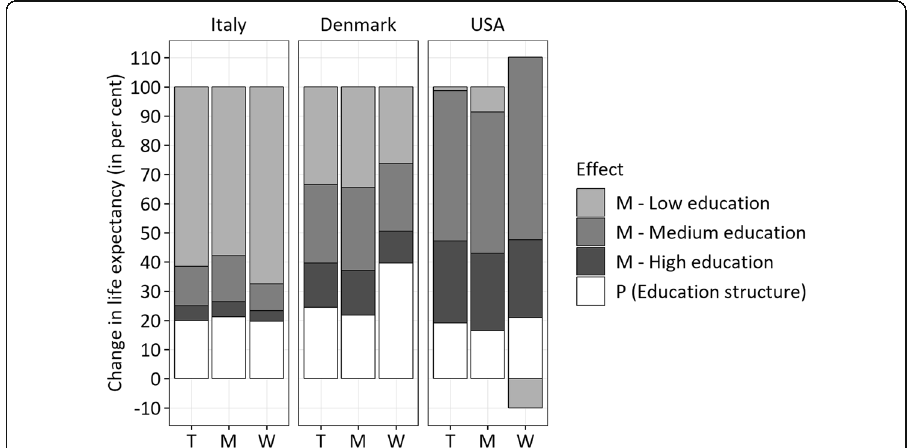
Fig. 2 Relative contributions of changes in mortality (M effect) and populations ’ educational structure (P effect) to differences in life expectancy at age 30 (in percent) for Italy (1991 – 2011), Denmark (1990 – 2010), and the USA (1990 – 2010), stratified by gender. Source: authors ’ own calculations; the data sources for the three populations can be found in the “ Data ” section. Note: T refers to total population, M is men, and W is